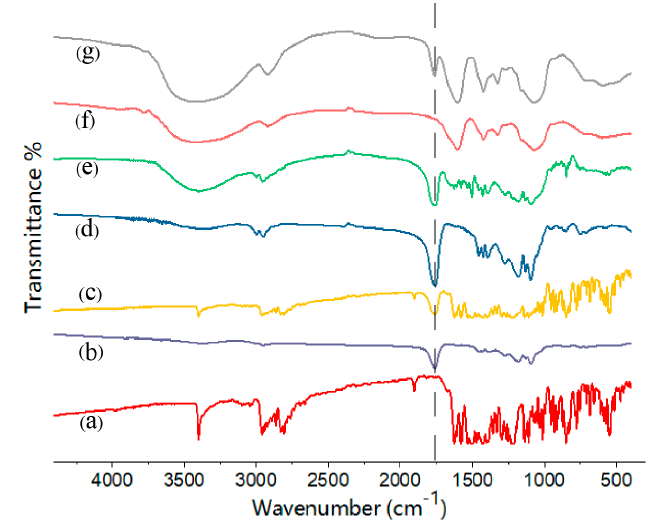
Figure 4. Fourier transform infrared (FT-IR) spectra of ( a ) gefitinib crystals, ( b ) P407/PLGA NPs, ( c ) physical mixture of gefitinib and P407/PLGA NPs, ( d ) GFB/P407/PLGA NPs, ( e ) GFB/FCPP NPs, ( f ) carboxymethyl β -glucan, and ( g ) GFB/FCPP-NEMs.